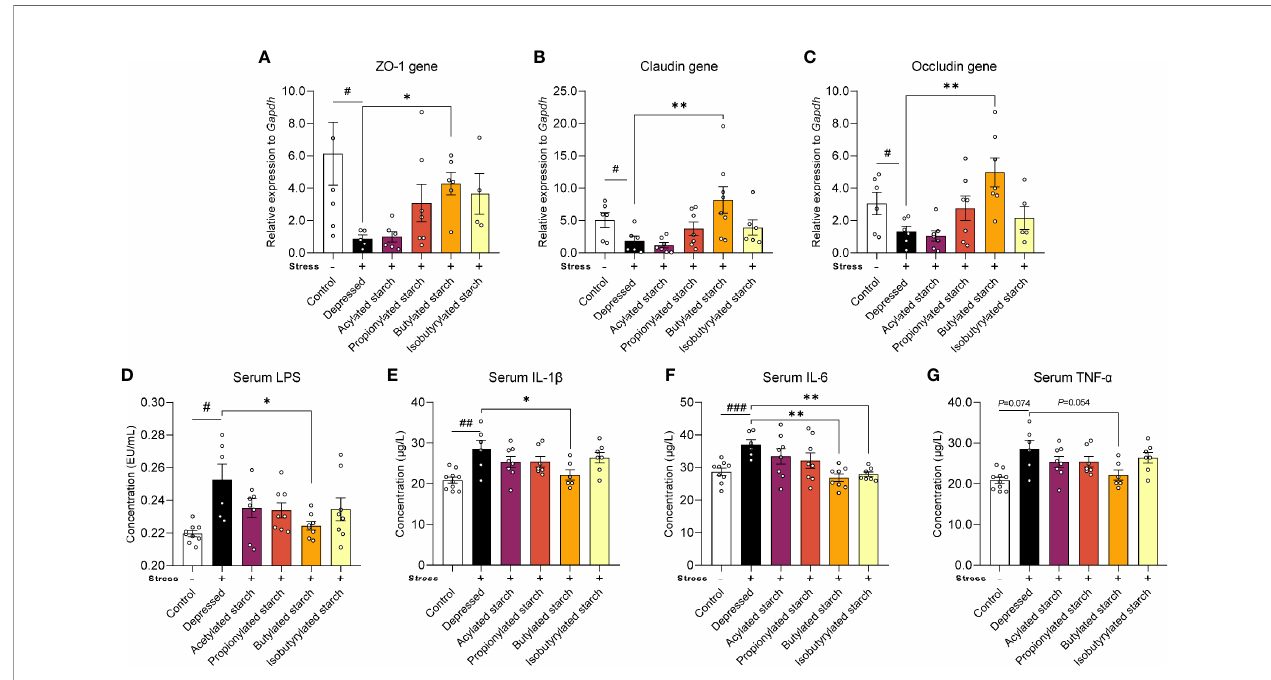
FIGURE 3 | The SCFAs levels in the ileum and cecum. (A – C) mRNA levels of the ZO-1, Claudin, and Occludin protein in the colon tissues. (D – G) Serum LPS and in fl ammatory cytokines (IL-1 b , IL-6, and TNF- a ) levels. Except for the control, all groups are given two-week chronic restraint stress. Data are mean with SEM (n=6- 10 per group for each test). # P <0.05, ## P <0.01, ### P <0.001 in the unpaired t-tests. * P <0.05, ** P< 0.01 in the unpaired